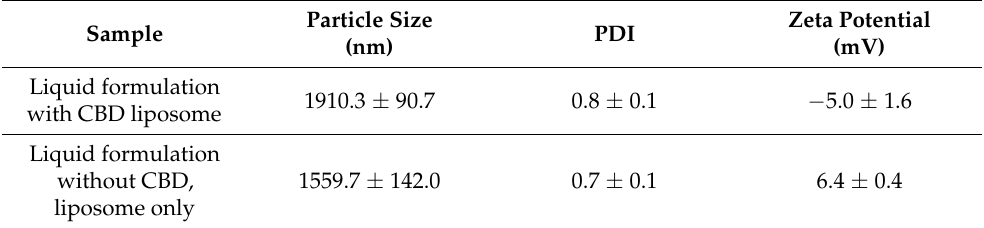
Table 2. The particle size, polydispersity index (PDI), and zeta potential of liquid formulations without (reference) and with